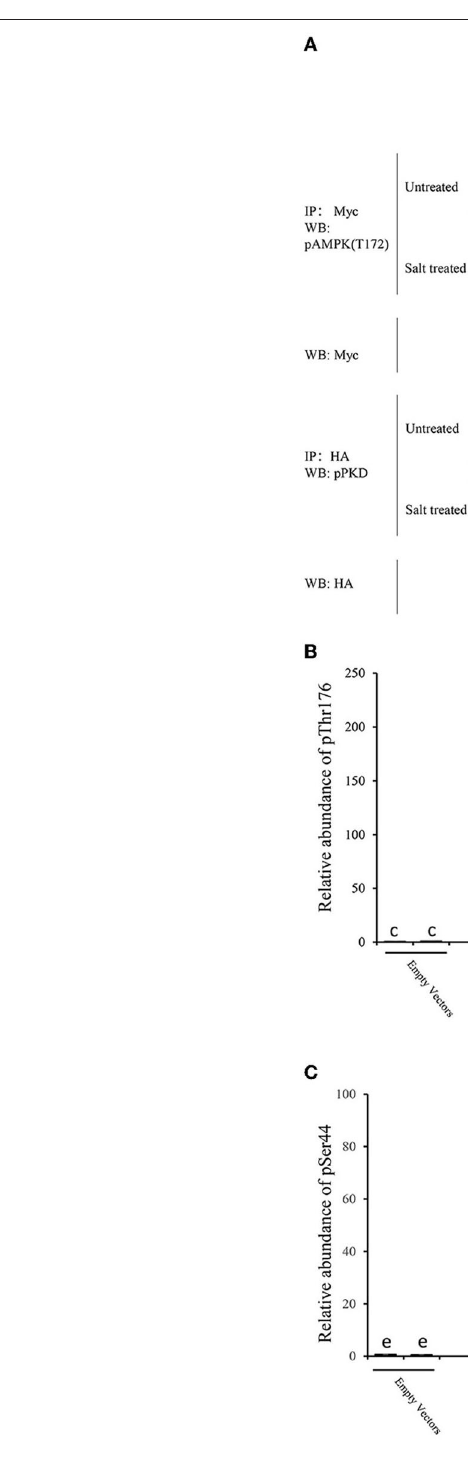
Frontiers in Plant Science |